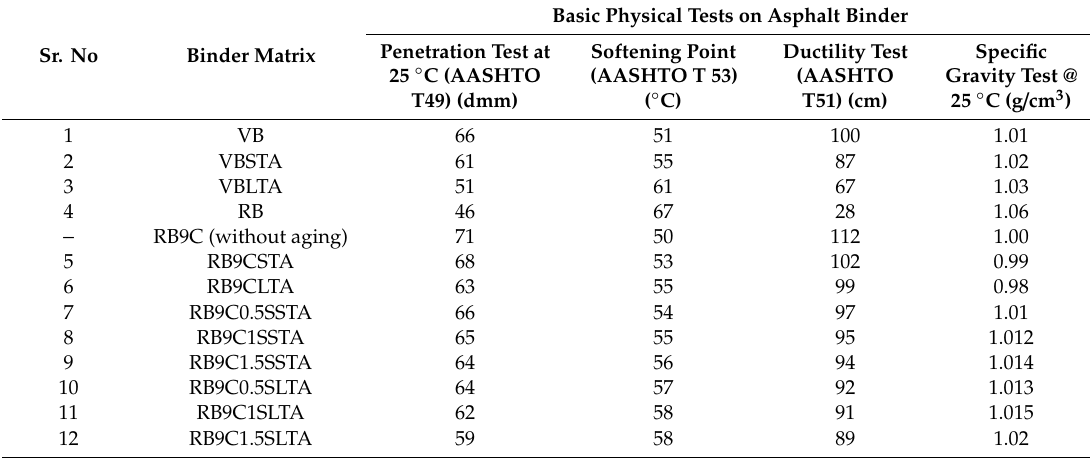
Table 2. Conventional properties of di ff erent asphalt binder samples.